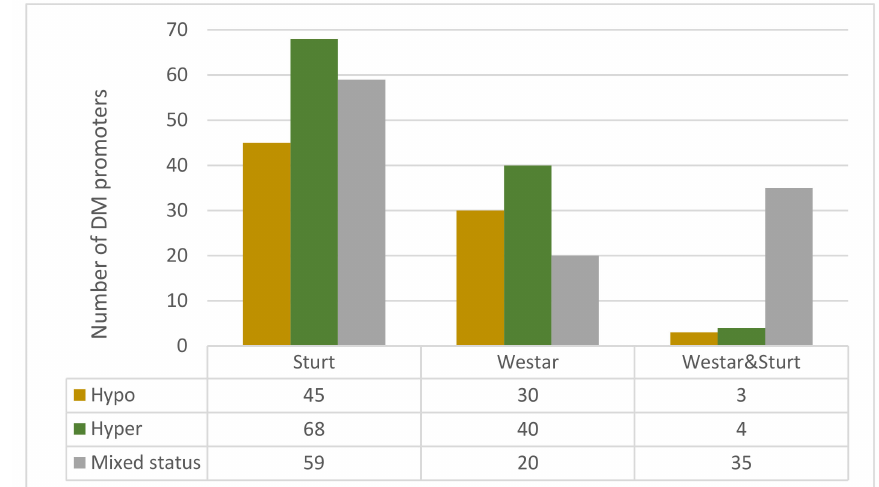
Figure 3. Number of di ff erentially methylated promoters of defence genes between leaves from control plants and leaves from infected plants with Leptosphaeria maculans of B. napus cultivars Westar (susceptible) and Sturt (resistant). Hypo: hypo-methylated, Hyper: hyper-methylated, Mixed status: in some leaves hypo-methylated and in some leaves hyper-methylated, DM: di ff erentially